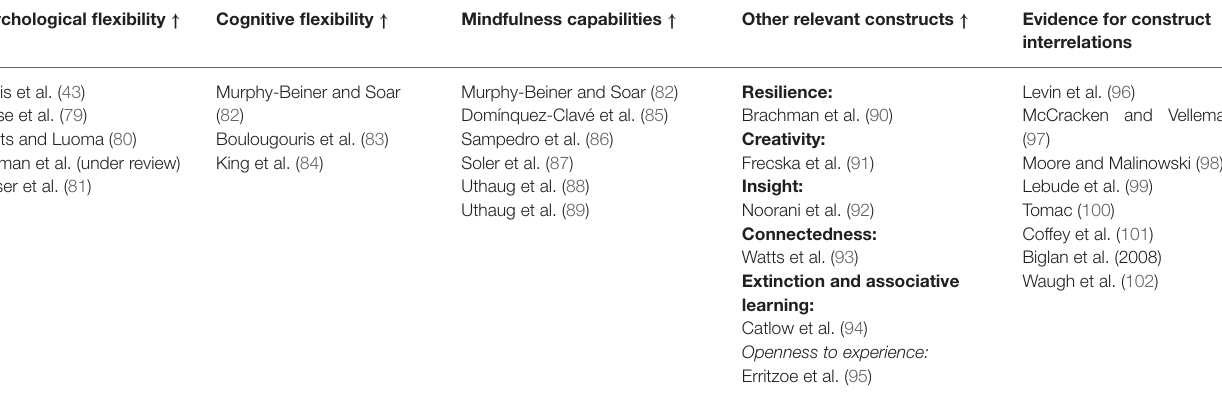
TABLE 1 | Table collating references to psychedelic or psychedelic-relevant studies showing increases in the relevant psychological constructs of processes of change. Psychological flexibility